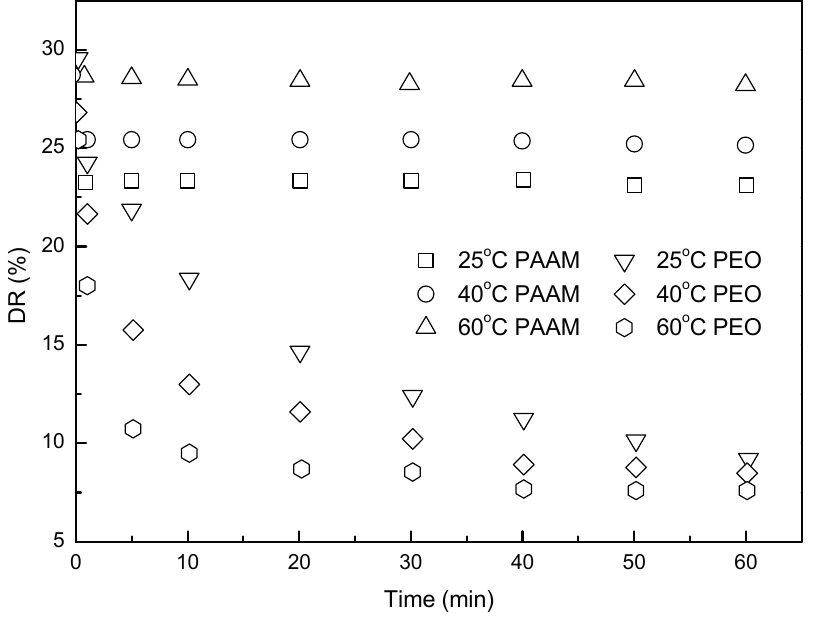
Figure 16. Drag reduction of 50 wppm PAAM and PEO at three different temperatures (Reprinted from